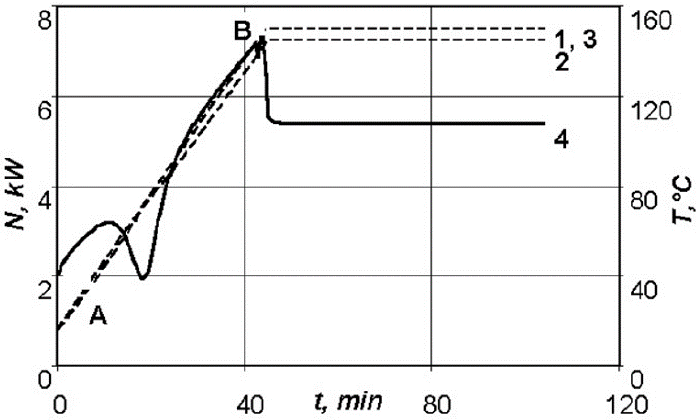
Figure 5. Dependences of parameters of the standard conditions of moulding of a package of 2 mm thick: 1 — temperature versus time on the lower surface of the product; 2 — temperature versus time on the upper surface of the product; 3 — temperature versus time for the theoretical conditions; 4 — power versus time.